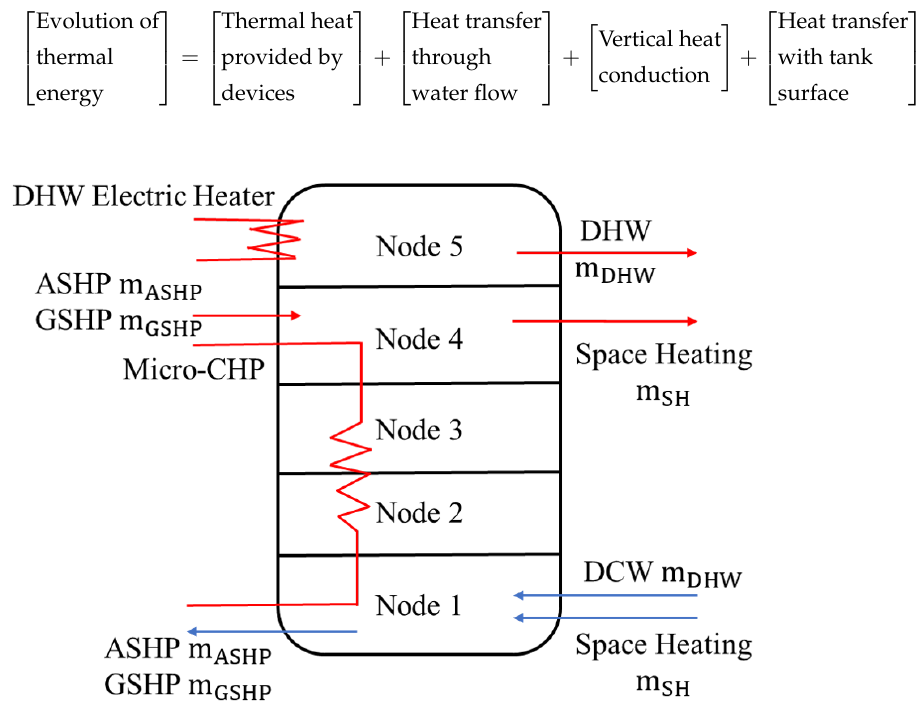
Figure 2. Schematic representation of the